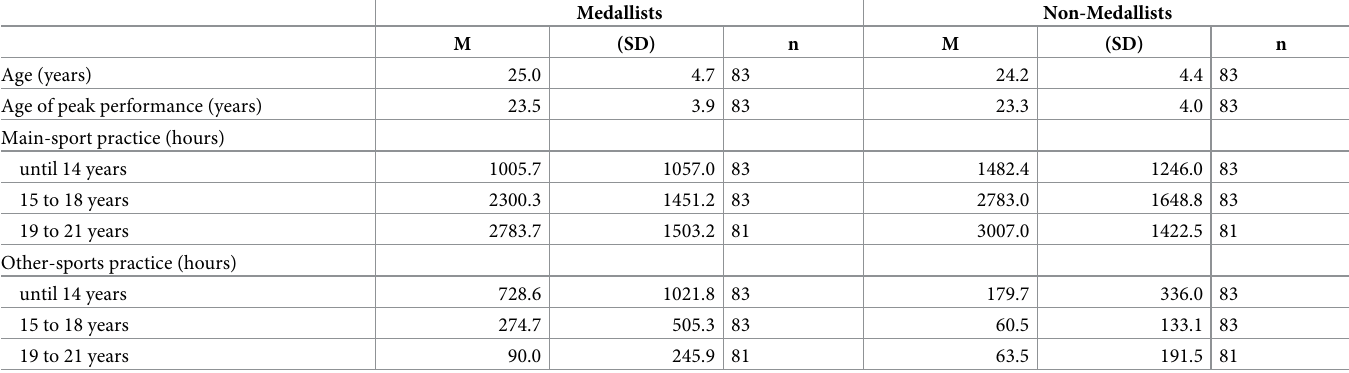
Table 2. Senior international medallists’ and non-medallists’ main-sport and other-sports coach-led practice hours through three age categories: Until 14, 15 to 18 and 19 to 21